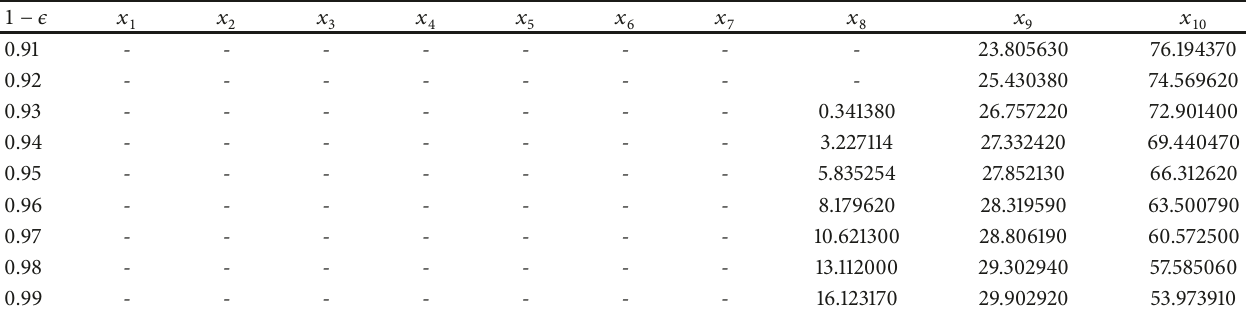
Table 5: The optimal portfolio strategies produced by nominal distribution model (31)